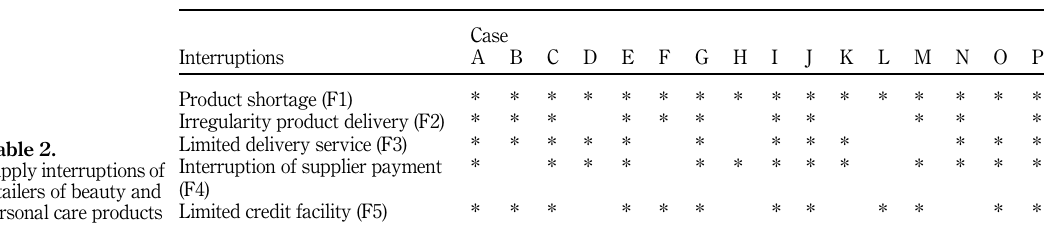
Table 2. Supply interruptions of retailers of beauty and personal care